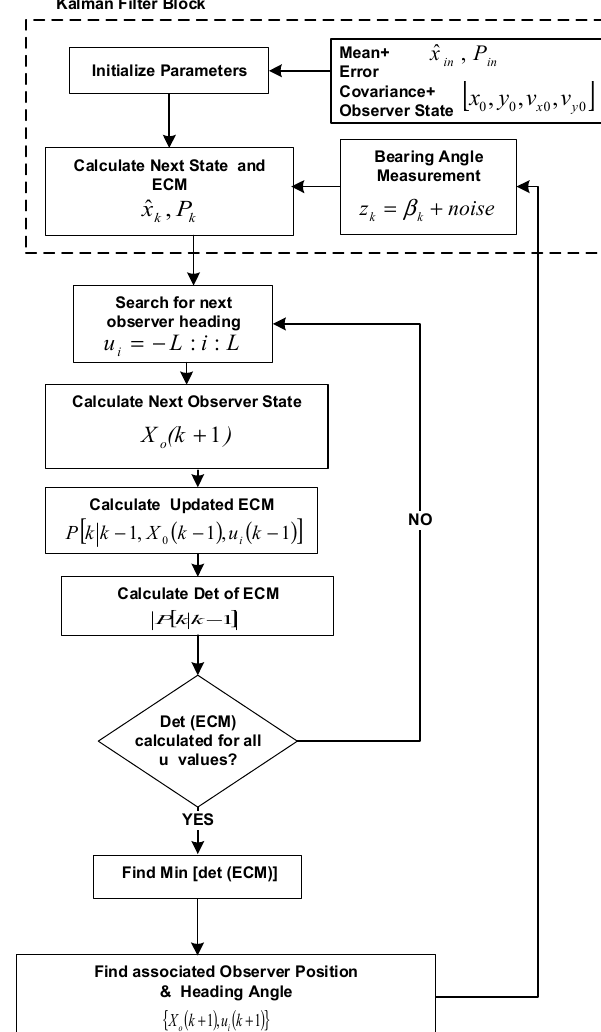
Figure 2. Flow chart for Sub-Optimal Observer Trajectory.